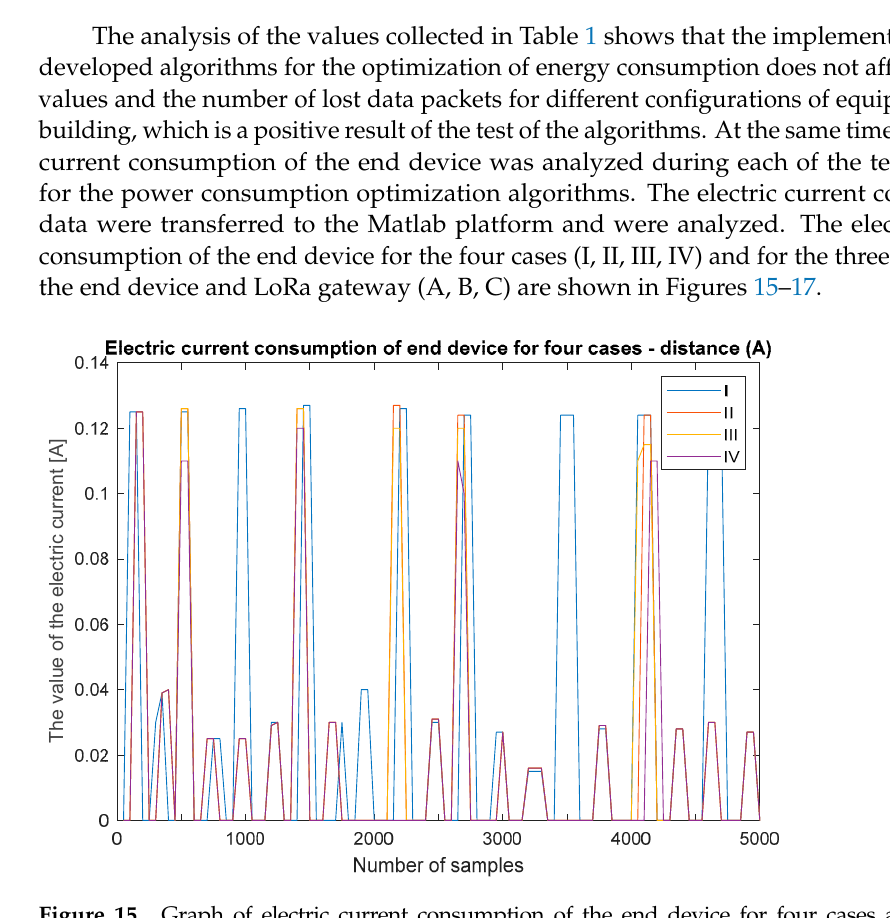
Figure 16. Graph of electric current consumption of the end device for four cases and devices— locations (B).